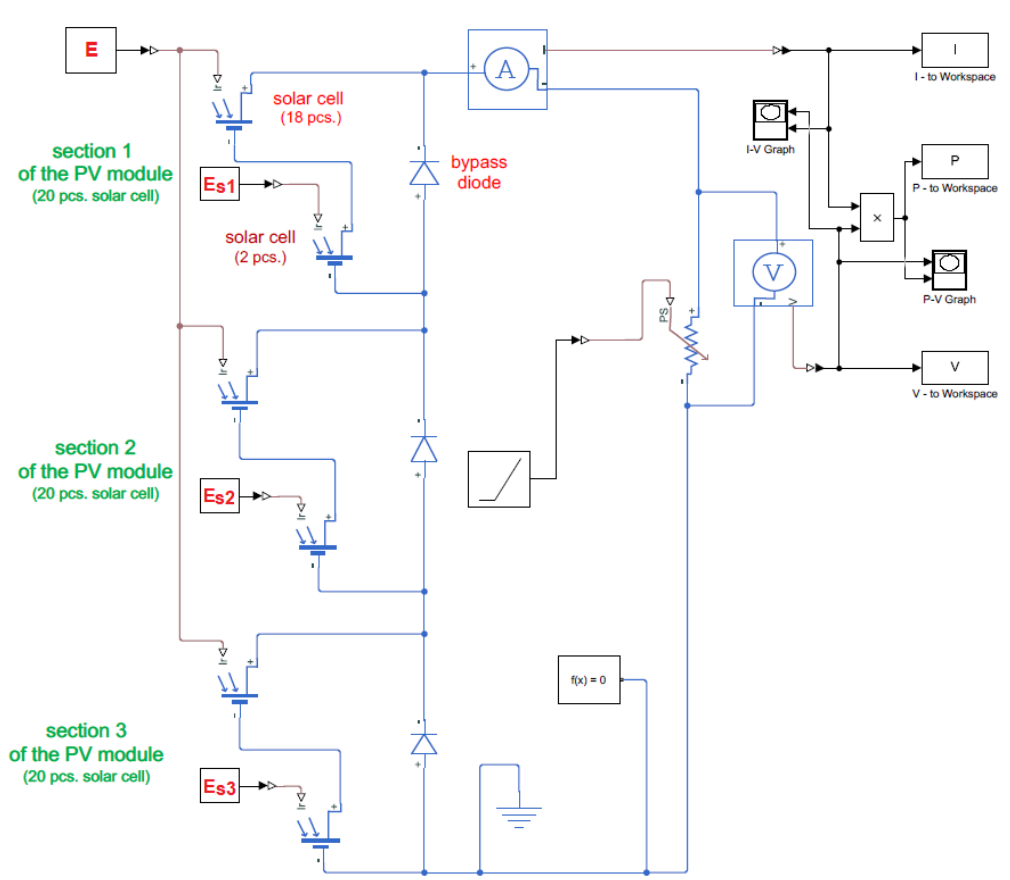
Figure 5. Simulation model of the I–V characteristics of PV module in the MATLAB/Simulink.